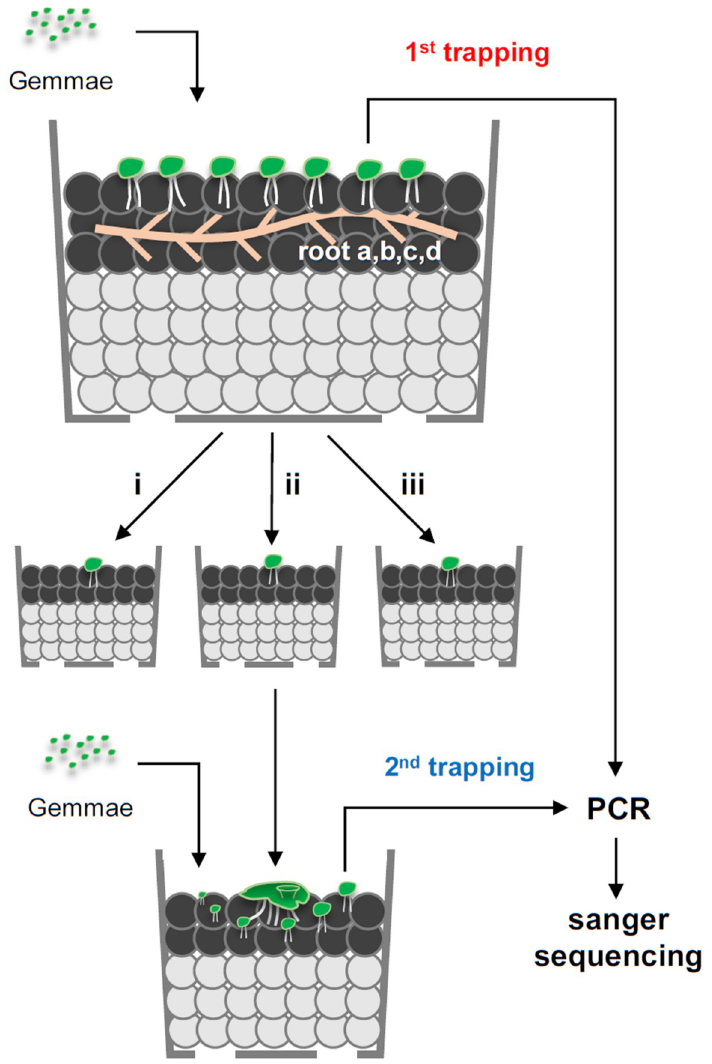
Figure 1. Trapping / isolation of native arbuscular mycorrhizal fungi (AMF) and DNA sequencing within liverwort. Schematic representation of the cultivation system of mycorrhizal Marchantia paleacea and AMF rDNA sequencing. M. paleacea gemmae harvested from gemmae cups were sown into soils where field roots (four types: a–d) were buried at a depth of ~5 mm. Gemmae (nascent thalli) were grown for 16–20 days, to allow colonization of native AMF from the roots. Three mycorrhizal thalli (mycothalli; i, ii, and iii) from the earliest colonization stage with red pigmentation in the central midrib area were transplanted to new pots. Three to ten mycothalli with red pigmentation were subjected to PCR and rDNA sequencing. M. paleacea gemmae harvested from the gemmae cups were sown around transplanted mycothalli (donor) for 20–30 days to allow colonization of the AMF from donor mycothalli. Six to eight mycothalli with red pigmentation per donor mycothalli were subjected to rDNA sequencing. DNA isolation, PCR, and Sanger sequencing were performed as previously described [31].